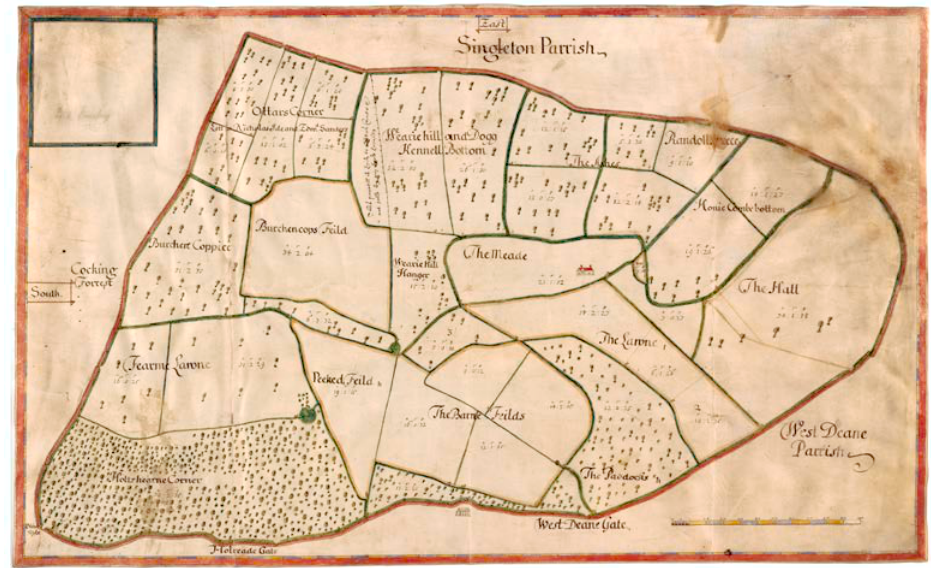
Fig. 4: The Lumley map drawn up sometime around 1630 (MS 18,014: reproduced by kind permission of the West Sussex Record Office.) Note the field names, gates and the lodge site. The map is orientated with North to the